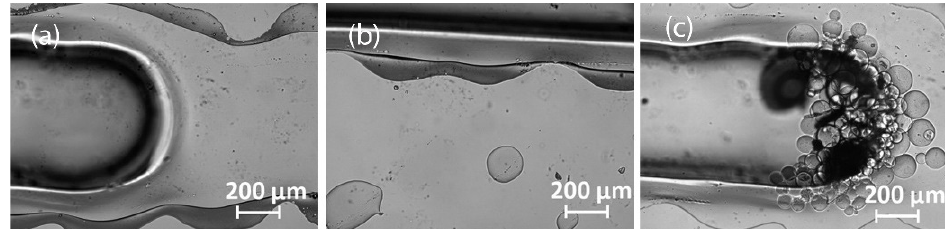
Figure 11. Sieve of a microfluidic chip replicated from a casting mold exposed to acetone vapor. ( a ) Sieve structure. ( b ) Surface next to the channel. ( c ) Sieve structure with retained spherical particles.